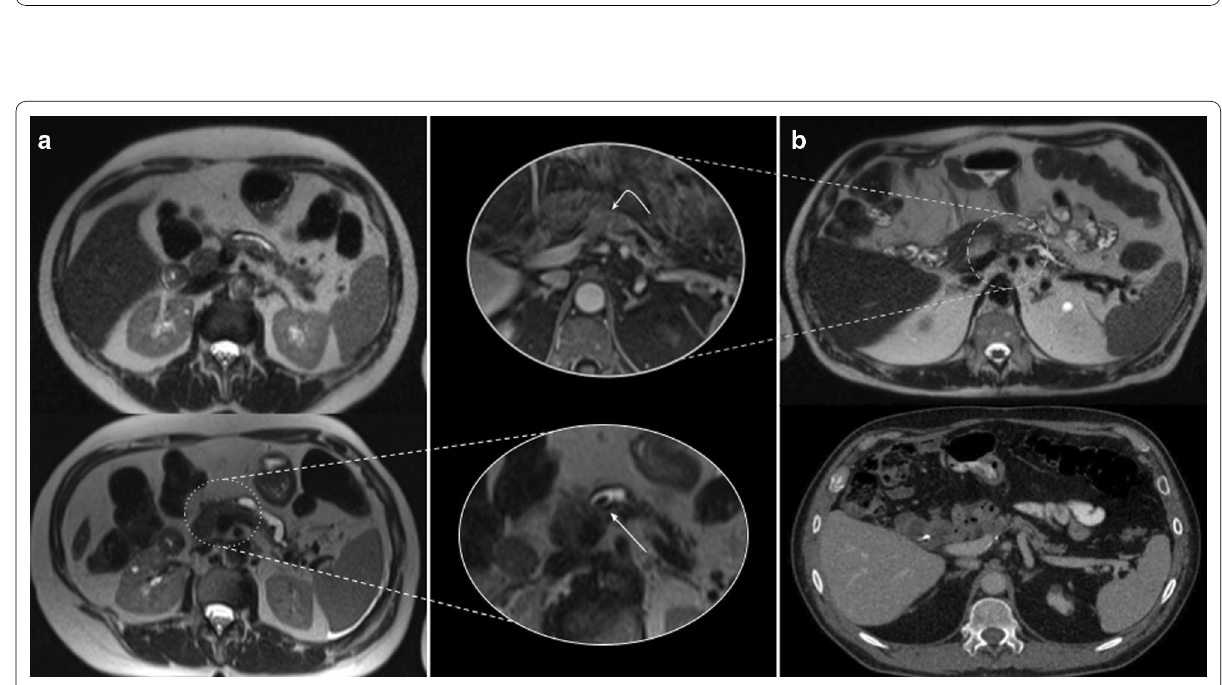
Fig.14 Benign duct dilatation vs. tumor recurrence. ( a ) 60-year-old female patient during acute abdominal pain. MRI showed pancreatic duct dilatation with filling defect (white straight arrow) just proximal to pancreaticojejunostomy. Acute stump pancreatitis was the final diagnosis. Endoscopic ultrasound confirmed mucoid plug related to pancreaticojejunostomy. Previous MRI (upper) denoted normal wirsung caliber. ( b ) MRI scan control in a 68-year-old male patient with pancreaticoduodenectomy due to pancreatic cancer. MRI performed three years after surgery reveals increased pancreatic duct dilatation related to an ill-defined hypovascular focal image in the pancreas body (curved arrow in magnified image). Lower: prior CT scan control denotes normal wirsung caliber. Endoscopy ultrasound guided biopsy confirmed adenocarcinoma